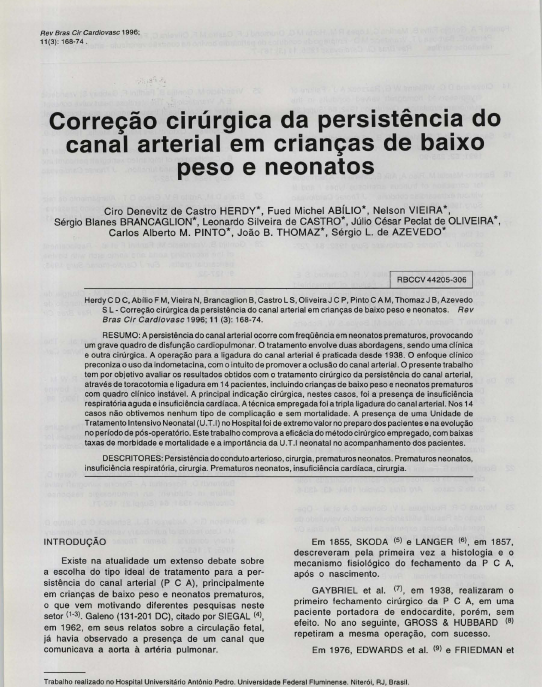
INTRODUÇÃO Existe na atualidade um extenso debate sobre a escolha do tipo ideal de tratamento para a per sistência do canal arterial (P C Aj. principalmente em crianças debaixo peso e neonatos prematuros, o que vem motivando diferentes pesquisas neste selar (1-3). Galeno (131·201 De), citado por SIEGAL (4), em 1962, em seus relatos sobre a circulação fetal, já havia observado a presllnça de um canal que comunicava a aorta à artéria